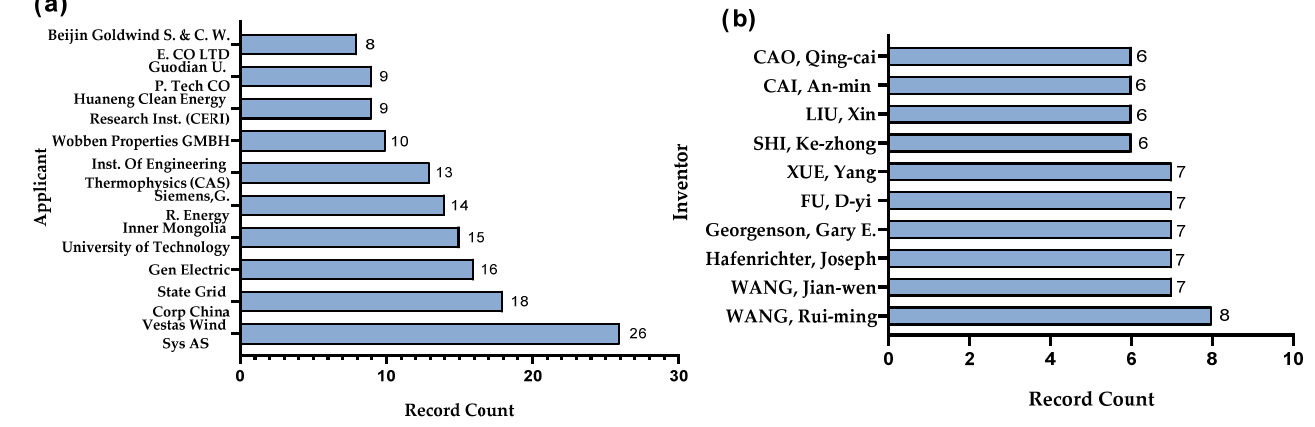
Figure 2. Analysis of the main ( a ) applicants and ( b ) inventors of the prospected technologies.